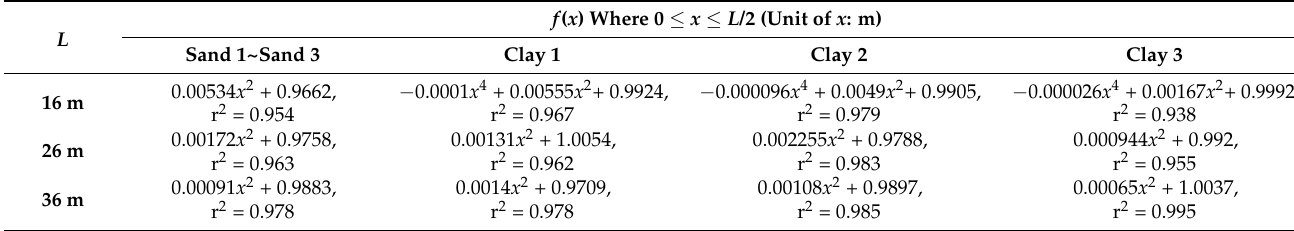
Table 5. The normalized function f ( x ) for the coefficient of subgrade reaction. f ( x ) Where 0 ≤ x ≤ L /2 (Unit of x :